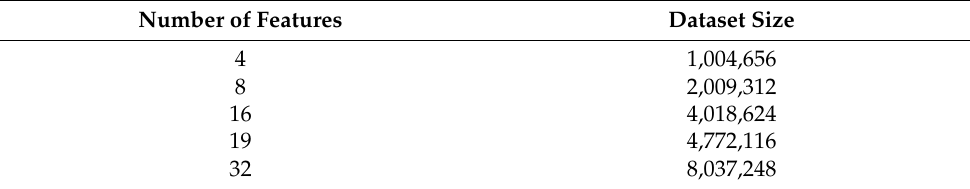
Table 5. Dataset size by number of features used in the reduction process.